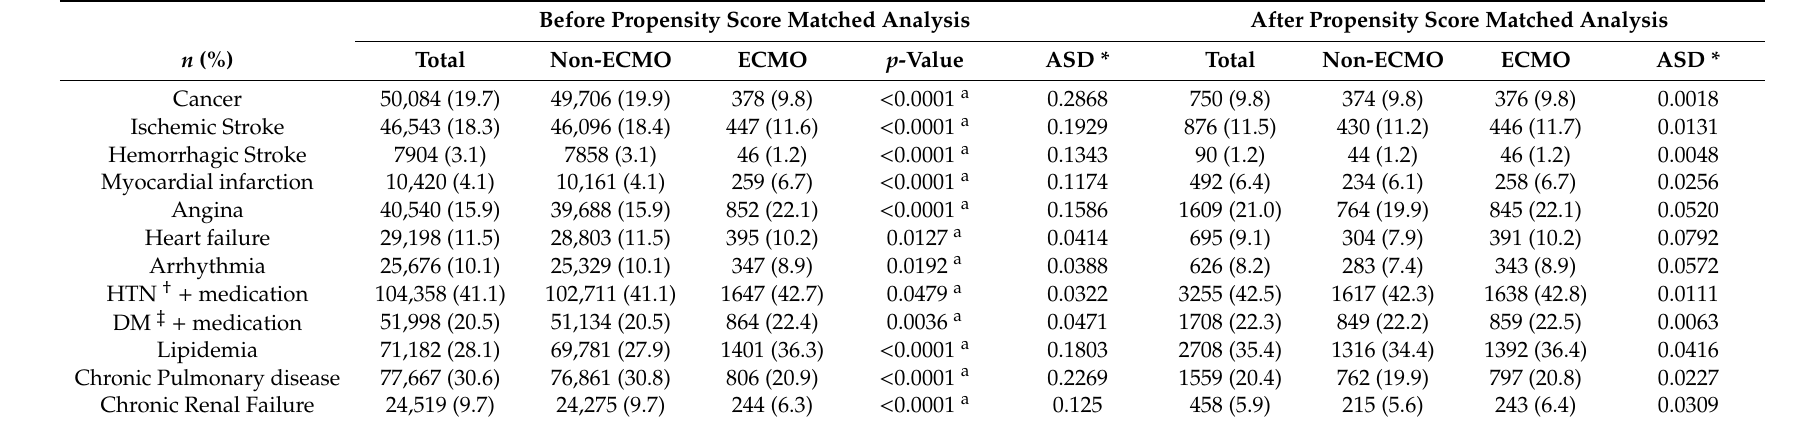
Table 2. Pre-existing diseases of the patients with cardiac arrest according to extracorporeal membrane oxygenation. Before Propensity Score Matched Analysis After Propensity Score Matched